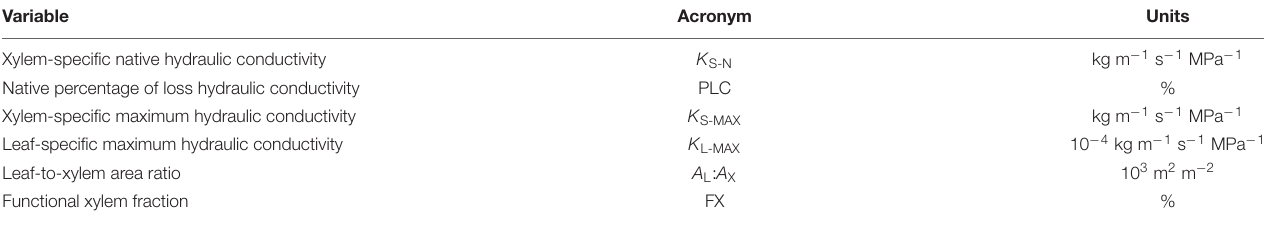
TABLE 2 | Branch-level traits measured.